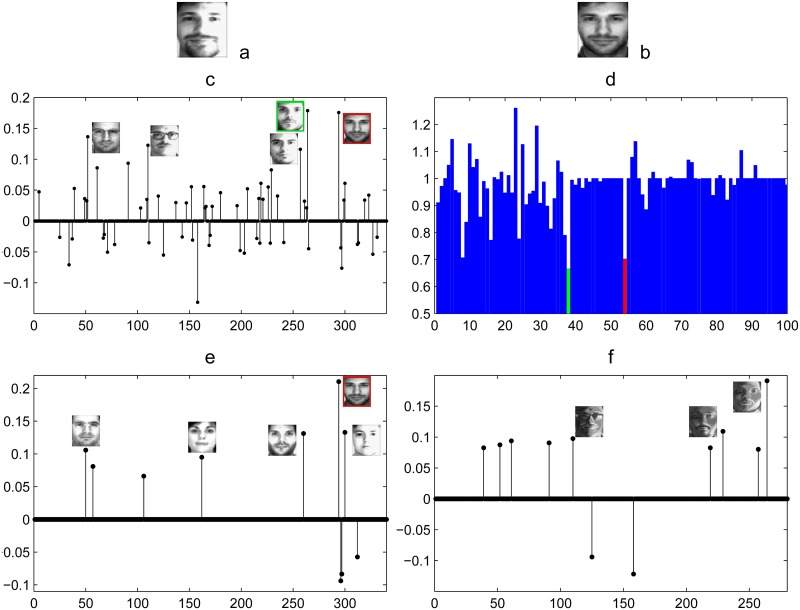
Comparison between SRC and LRSE+SC.(a) A test face image from subject 54 in the AR database: the second row is the SRC result, and the third row is the LRSE+SC result. (b) The only one training sample of subject 54. (c) Sparse coefficients associated with the original training sample dictionary. (d) Reconstruction residuals with respect to the coefficients for different classes; the red bar indicates the correct class. (e) Sparse coefficients associated with low rank supervised dictionary. (f) Sparse coefficients associated with sparse intra-class variant dictionary. Images bounded by red rectangles are the correct class, and the green rectangle ones are faces from other subjects.